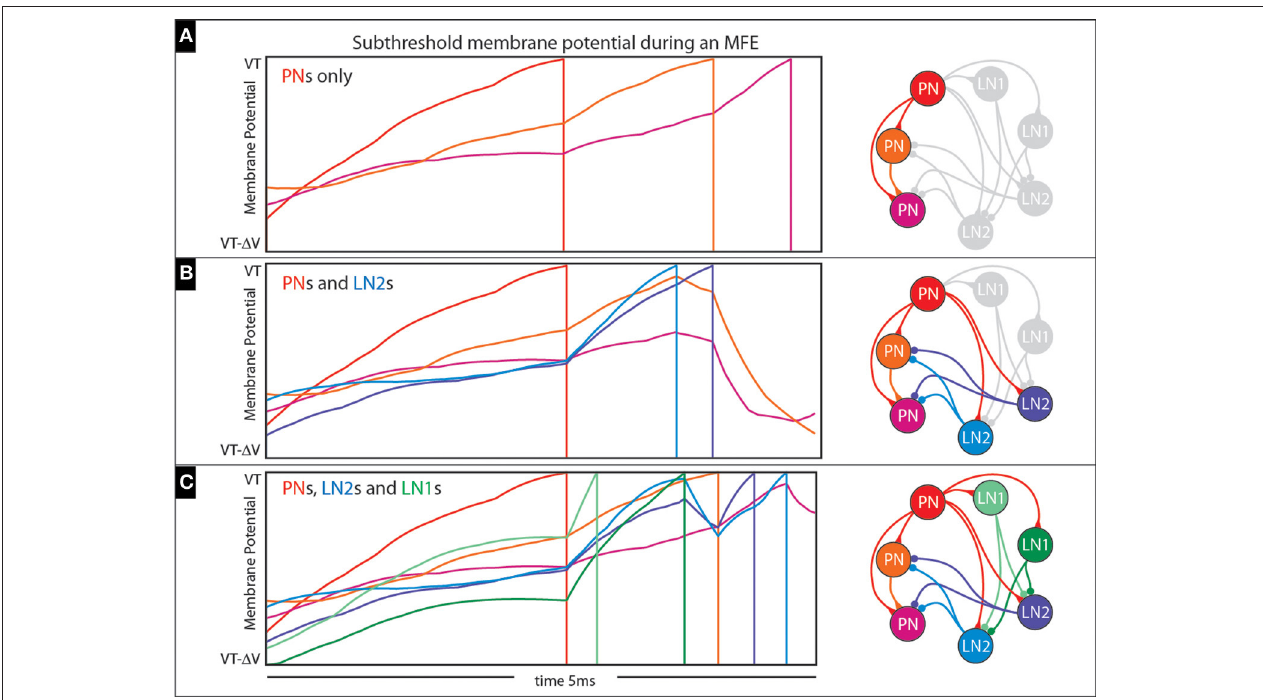
FIGURE 14 | Illustration of multiple-firing-events (MFEs): (A–C) Here we use a collection of small networks to illustrate the kinds of chain-reactions we see in our simulations. See text for details.